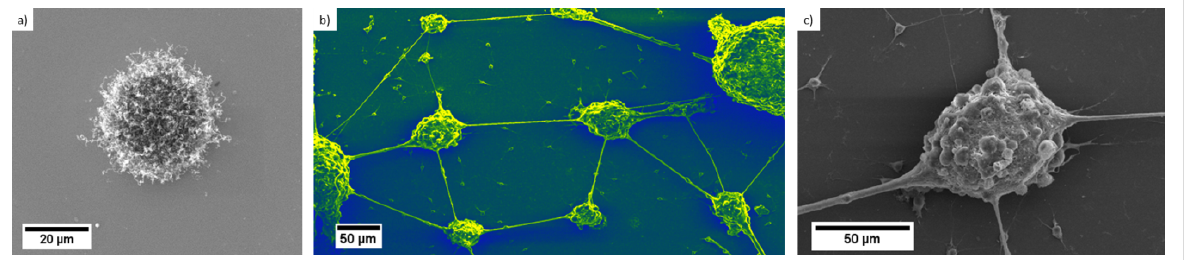
Figure 2: SEM images of neurons cultured on randomly oriented CNT islands. Panel a) depicts a single CNT island with a diameter of ca. 30 µm. In b) and c) after 21 days neurons have accumulated in vitro onto those CNT islands. Neuron cells prefer to grow and adhere onto the CNT islands, forming intimate clusters around individual CNT islands with strong interconnections between the islands (the distance from CNT centre to CNT centre is 200 µm).